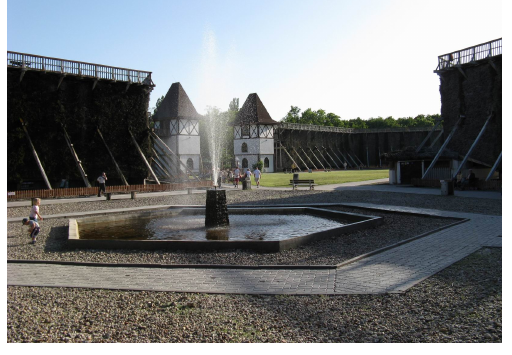
Figure 1: Spa park in Inowroclaw [Photos by